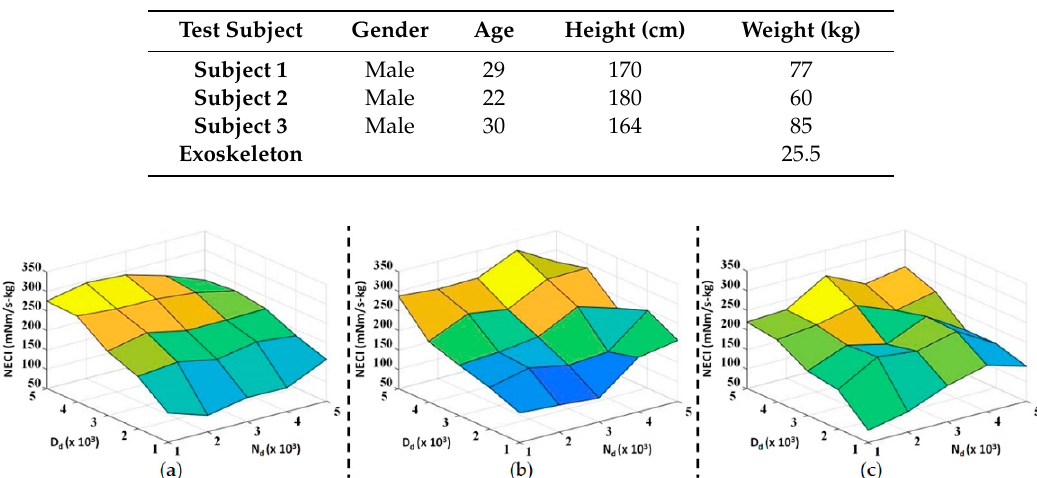
Table 2. Basic information of the test subjects.